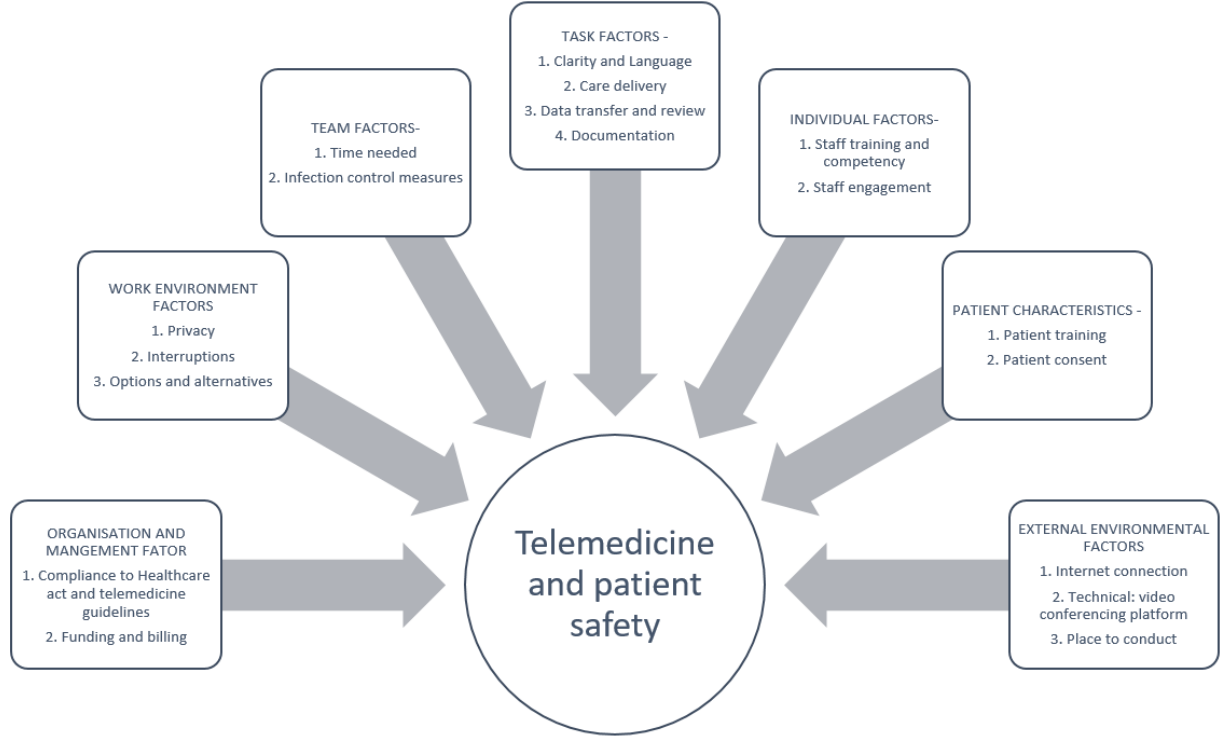
Figure 3. Core elements of patient safety while adopting telemedicine in dialysis unit in the Singapore setting.